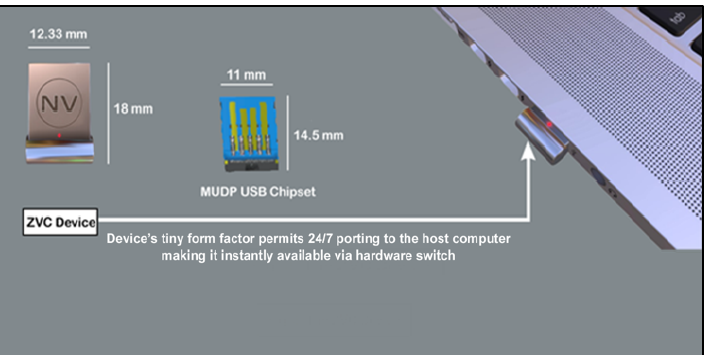
Figure 7. Illustration of the security of a switchable ZVC hardware wallet that incorporates both the SOS and ICOS modules of ZVC.